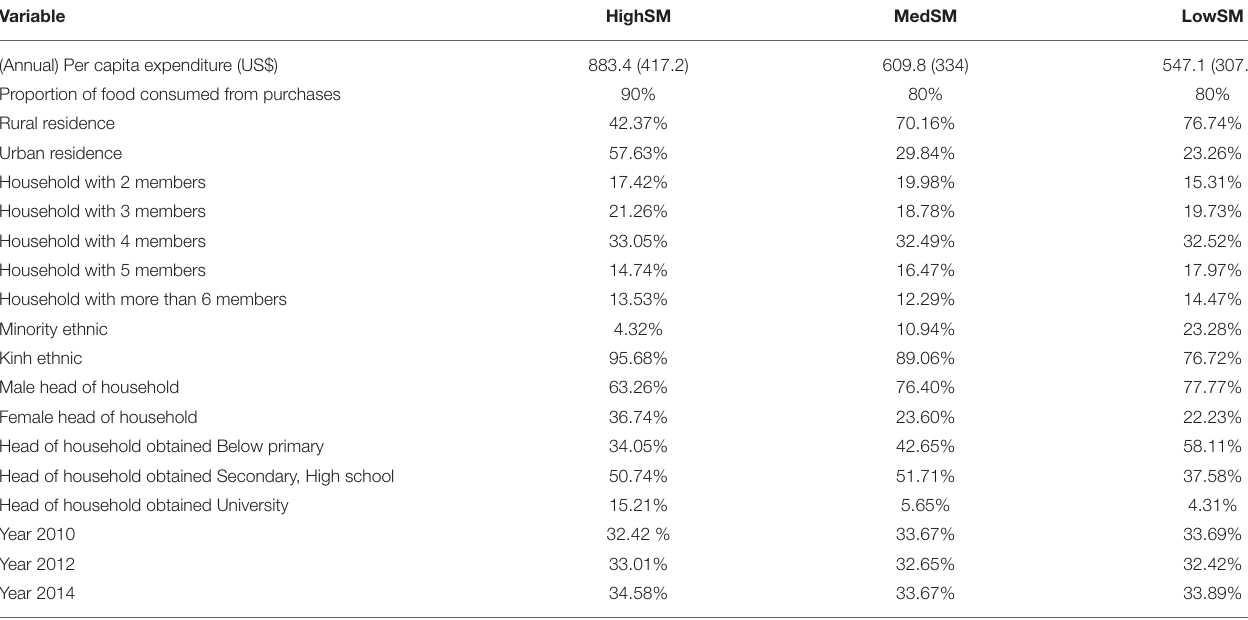
TABLE 3 | Descriptive statistics of social, economic and demographic variables by supermarket